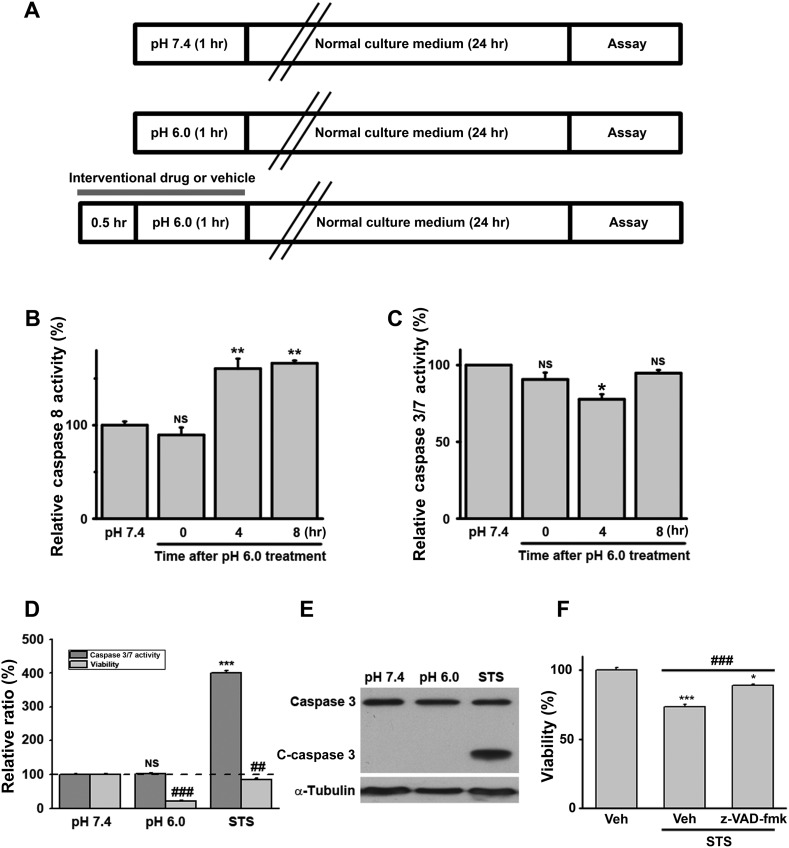
Acid (pH 6.0) treatment does not induce caspase 3/7 activation in cultured mouse cortical neurons.(A) Scheme of acid treatment and assay protocols. Unless indicated otherwise, all interventional drugs were applied 30 min before and were present during the pH 6.0 treatment. (B) Moderate activation of caspase 8 after pH 6.0 treatment (n=3, **p<0.01; NS, no statistical significance, vs pH 7.4). (C) Caspase 3/7 were not activated after pH 6.0 treatment (n=3, *p<0.05; NS, no statistical significance, vs pH 7.4). (D) Caspase 3/7 activity and neuronal death were tested 8 hr after 1 hr of pH 6.0 treatment from the same batch of neurons. Staurosporine (STS, 100 nM) strongly increased caspase 3/7 activity. However, no increase in caspase 3/7 activity was observed even though severe neuronal death occurred (n=3, for caspase 3/7 activity, ***p<0.001; NS, no statistical significance, vs pH 7.4; for neuronal death, ##p<0.01; ###p<0.001, vs pH 7.4). The dashed line indicates caspase 3/7 activity and neuronal viability at pH 7.4. (E) No cleavage of caspase 3 (C-caspase 3) was detected after treatment with the pH 6.0 solution. Cleavage was seen with the STS treatment. (F) z-VAD-fmk significantly inhibited STS-induced apoptotic neuronal death (n=3, ***p<0.001; NS, no statistical significance, vs vehicle (Veh); ###p<0.001, vs STS+Veh), demonstrating that z-VAD-fmk was effective (control for Figure 1B).